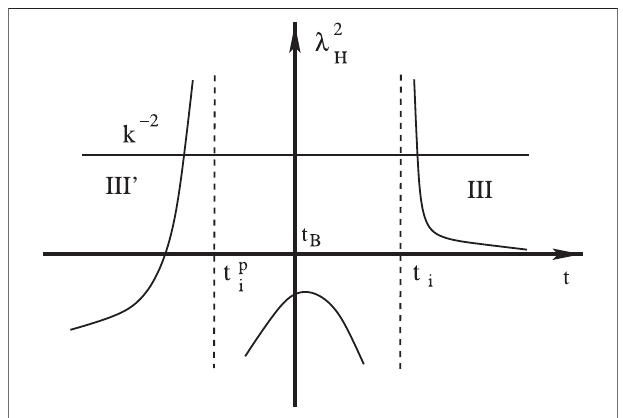
FIGURE 8 | Schematic plot of λ 2 H de fi ned by Eq. 4.10 in mLQC-I for the quadraticpotentialinthehybridapproach,where s ( t i ) (cid:2) s ( t p i ) (cid:2) 0,and t (cid:2) t i is the starting time of the in fl ationary phase. During the slow-roll in fl ation, we have λ 2 H ≈ L 2 H / 2 (Region III). In the contracting phase, the background is asymptotically de Sitter. The evolution of the universe is asymmetric with respecttothebounce.Inparticular, λ 2 H isstrictlynegativefor t p i < t < t i ,whilefor t ≃ t p − i the “ generalized ” comoving Hubble radius λ 2 H becomes positive and large. However, as t decreases, λ 2 H becomes negative again. Although the values of t i and t H depend on the initial conditions for the background evolution, for example, when ϕ B (cid:2) 1 . 27 m pl at the bounce, t i ≈ 7 . 55 × 10 4 t pl and t H ≈ − 21 . 85 t pl , the qualitative behavior ofthe comoving Hubbleradiusis robustwithrespecttothechoiceoftheinitialconditionsaslongasthebounce is dominated by the kinetic energy of the scalar fi eld.